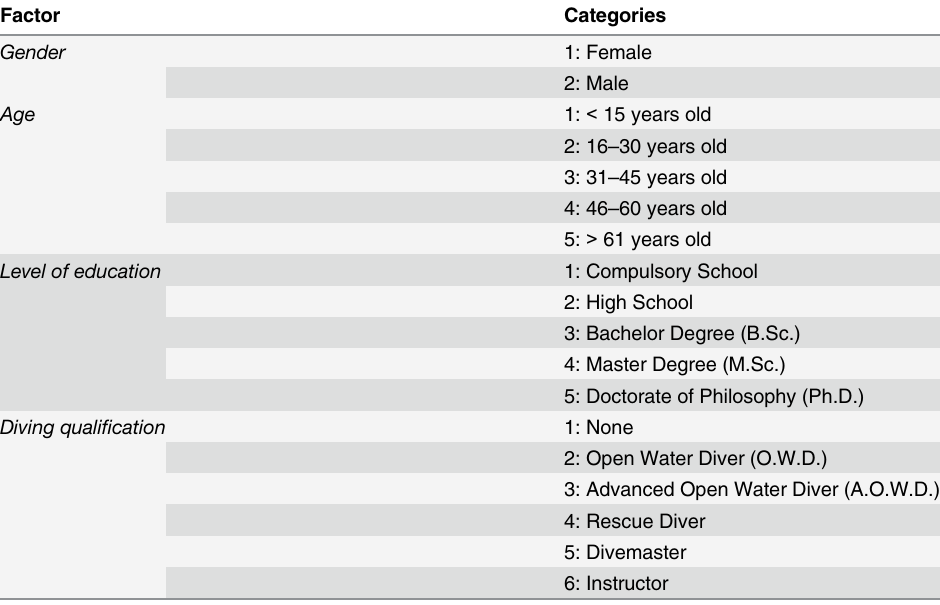
Table 1. Volunteers ’ personal and demographic data collected to identify factors that could influence the initial level of environmental awareness and its improvement after the project. Factor